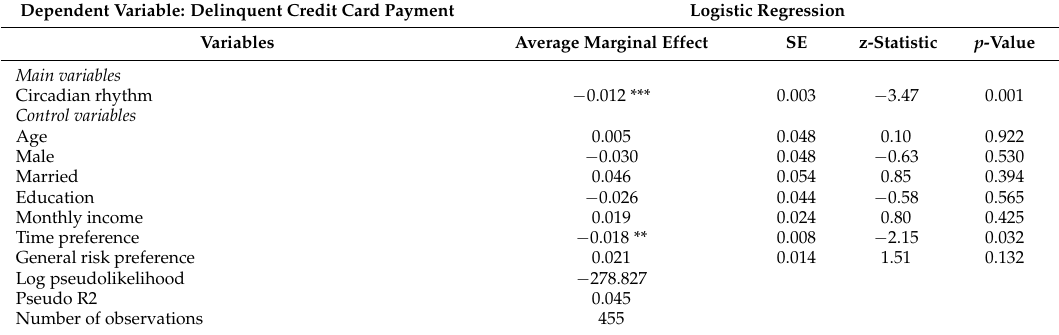
Table A1. The effect of circadian rhythm on likelihood of delinquent credit card payments in logistic regression.